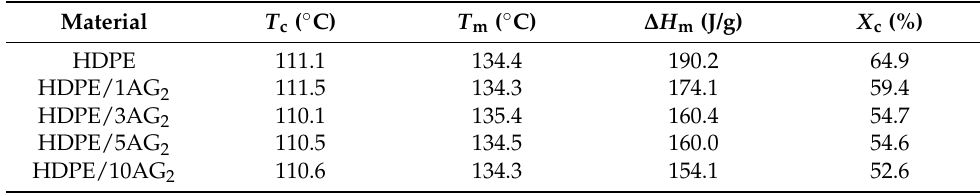
Table 2. DSC results on HDPE and HDPE/AG 2